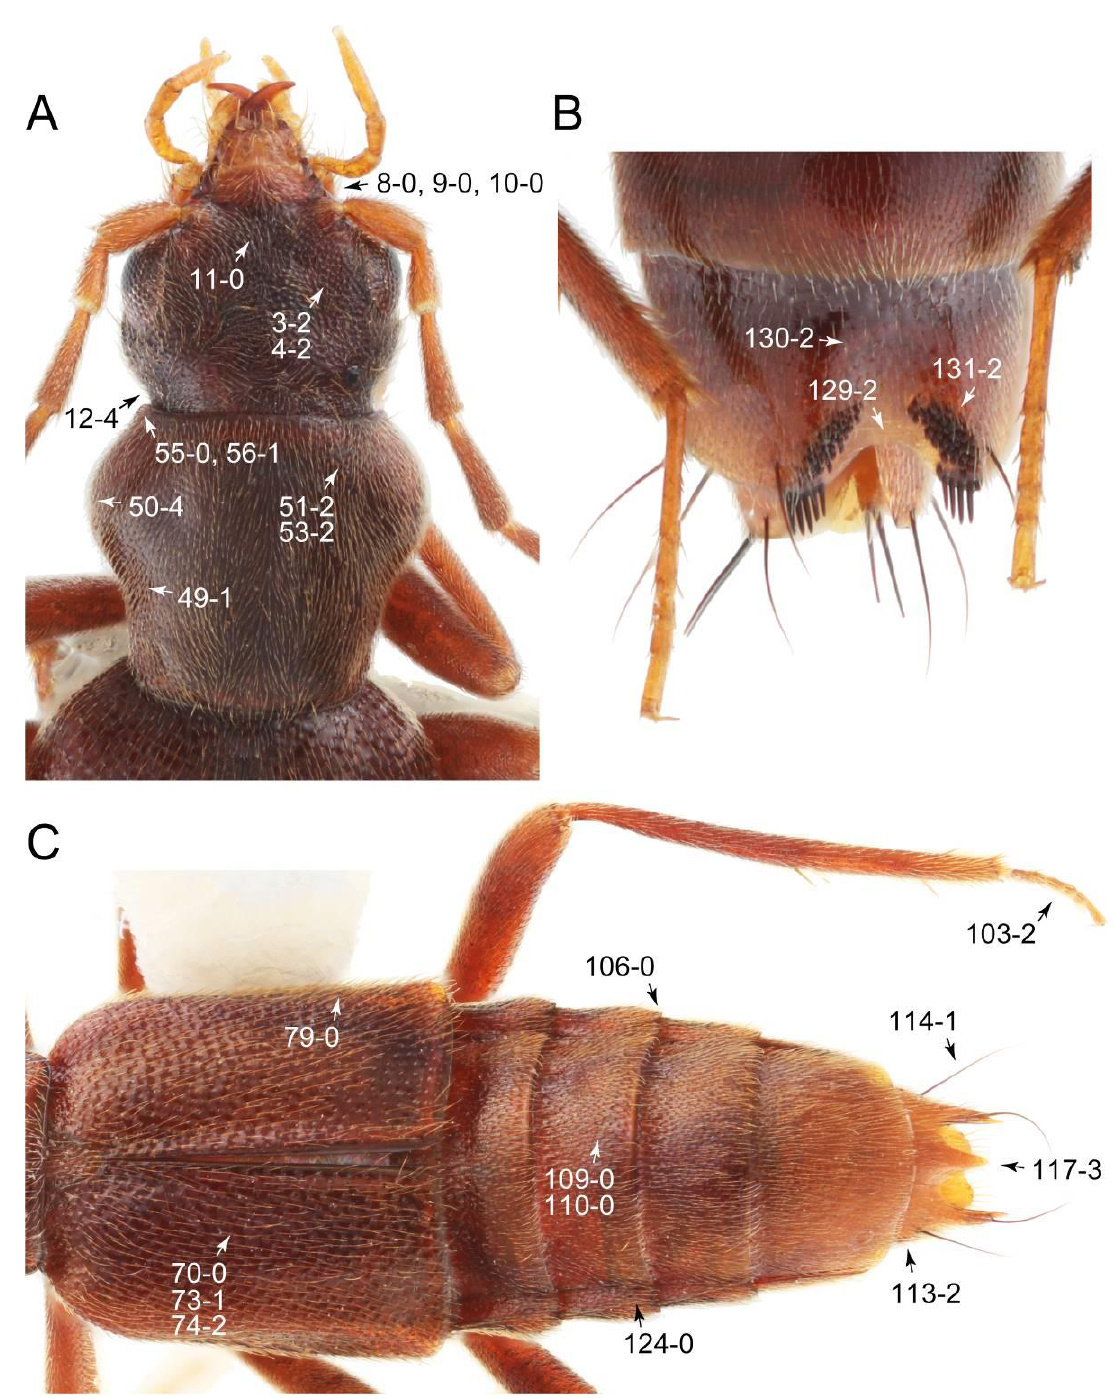
Figure 44. Photographs of body parts of Deropini ( Derops ), enlarged. ( A ) head and pronotum of Derops longicornis , dorsal view. ( B ) male sternite VII of Derops longicornis , ventral view. ( C ) elytra, hindleg, and abdomen of Derops divalis , female, dorsal view. Characters and character states (format X-X) are indicated on each